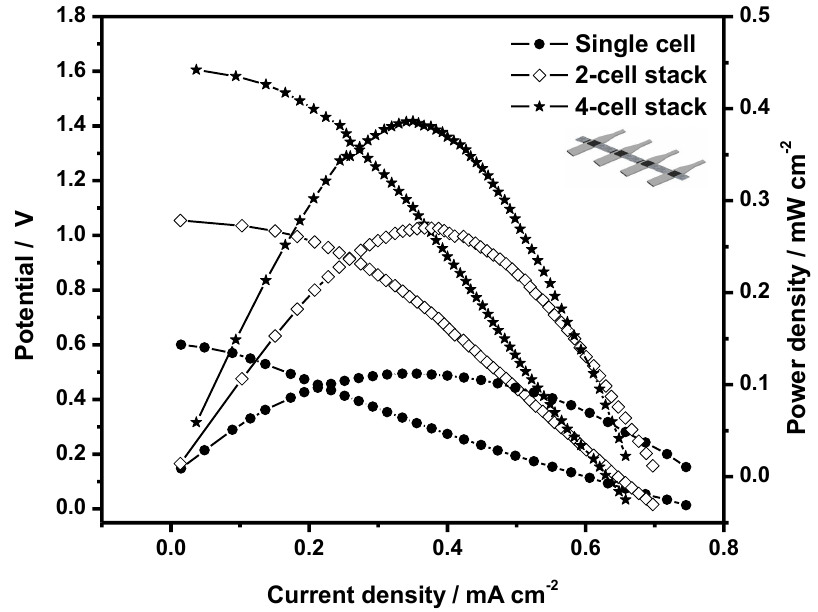
Figure 8. Polarization and power density curves of PtRu/C and Pt/C as anode and cathode, respectively in 2- and 4-cell paper-based microfluidic stacks using Coca Cola R